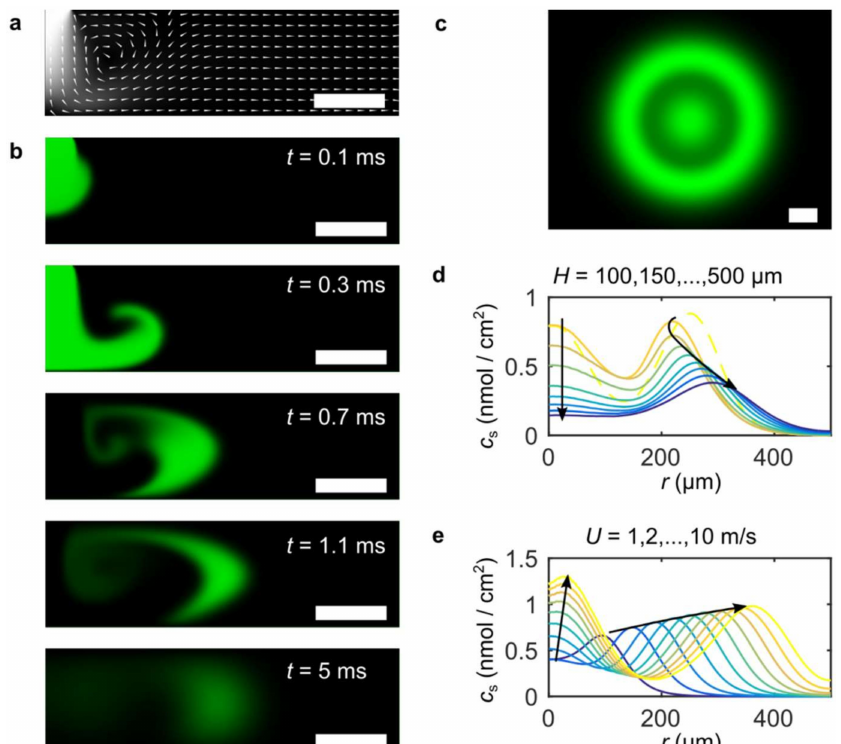
Figure 4. Results of numerical modelling. ( a ) Side view of the quasi-stationary flow field (gray scale: absolute value, arrows: direction) generated in the micro-gap by the evaporation of solvent residues from the material layer during laser irradiation. The left side of the picture corresponds to r = 0, the donor substrate is located on the top of the domain, the acceptor on the bottom; the right end is open. ( b ) Snapshots of the volume concentration (side view) during different flow phases: initially, the inflow jet (5 m/s) carrying the compounds hit the acceptor surface and turned radially outward (first and second picture). In a second phase (here, between t = 0.5 ms and t = 1 ms ), the inflow continued but did not bring in any more new compounds (third picture), until the flow stopped completely. Then, the compounds formed a ring-shaped cloud that diffused slowly to the substrates (fourth and fifth pictures). The scale bars represent 100 µ m. ( c ) Reconstructed deposition pattern (top view) resulting from the simulation shown in ( b ). The spot exhibits a center core and a ring. The scale bar represents 100 µ m. ( d ) Radial surface concentration profiles of the simulated deposition patterns for different distances between the substrates. As indicated by the eye guiding arrows, the core of the spot was vanishing, and the ring was decreasing more slowly and moving slightly outwards. The height of the gap simulated in ( b ) was 150 µ m; ( e ) Simulated radial profiles of the spots for different inlet velocities; the arrows illustrate that the core deposition was stronger with respect to the ring formation when the jet transfer was faster. Furthermore, for higher velocities, there was a growing dimple at the center. As expected, faster flows carried the ring farther away from the center. Profiles in ( d ) and ( e ) correspond to the time t = 5